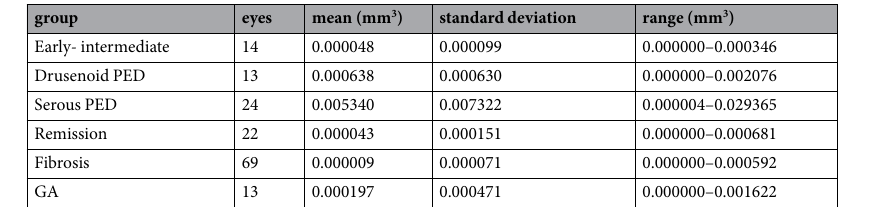
Table 2. The volume of HRF with RPE in each group. HRF, hyperreflective foci; RPE, retinal pigment epithelium; PED, pigment epithelial detachment; GA, geographic